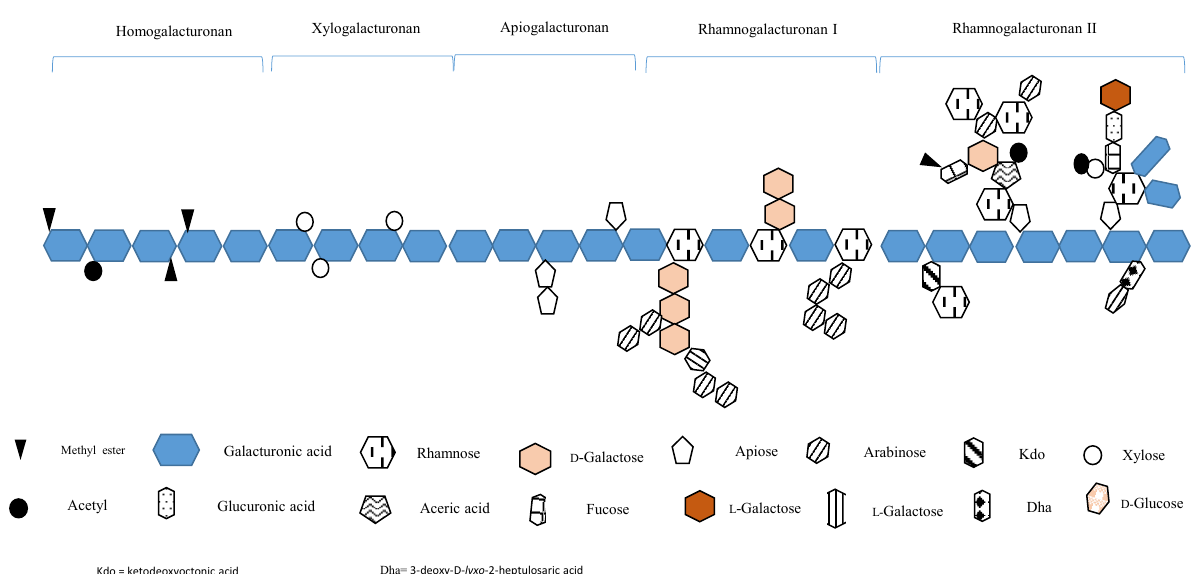
Figure 1. Pectin structure [15,16].